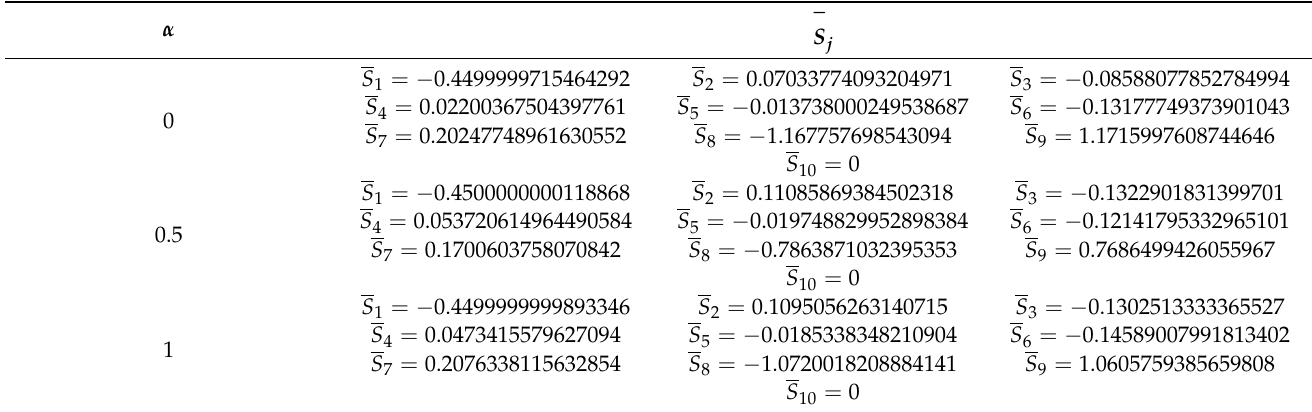
Table 4. Upper auxiliary convergence parameters of the tenth-order FF-OHAM for solving Equation (47) at ω = 1.9, x = 0.1, for all α ∈ [ 0,1 ] .